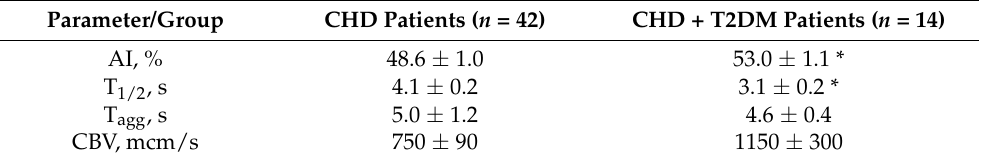
Table 3. The comparison of CHD patients with and without T2DM. The averaged values and the standard errors of the sample mean are presented. The p -value was calculated by a two-tailed t -test with unequal variance.